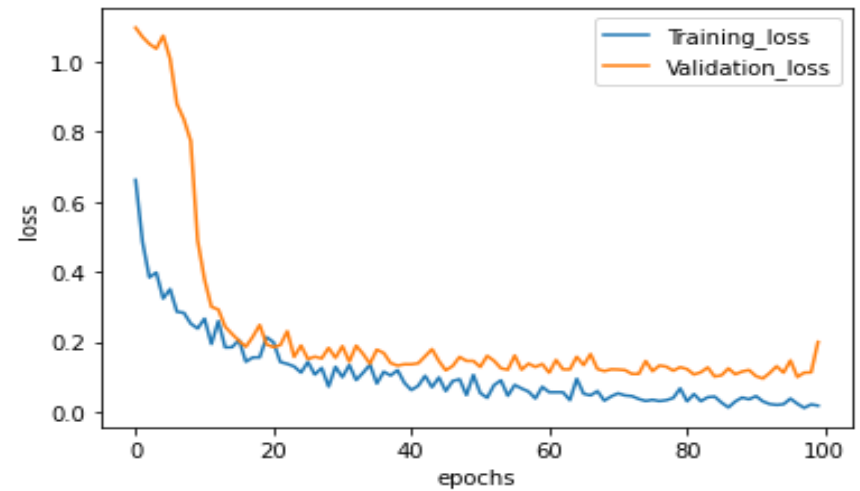
Figure 10. Accuracy and loss performance of the proposed MobiRes-Net model.